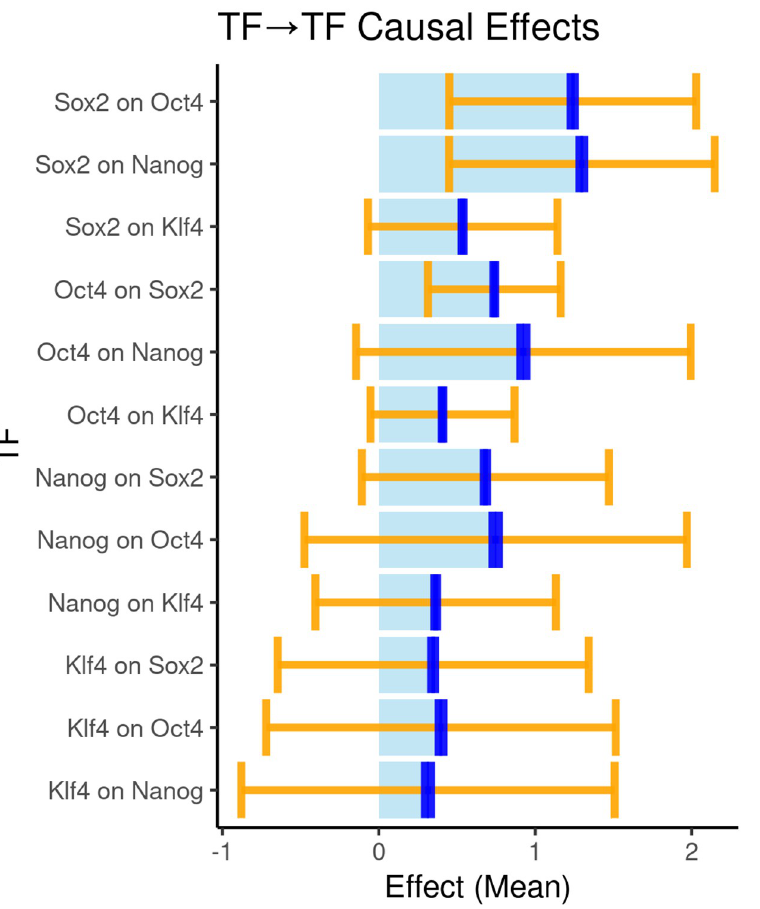
Fig 3. Global CE estimates. Global CEs for all pairs of TFs predicted by BPNet with ± 2 τ (orange) and ± 2 σ (blue) ranges around the mean